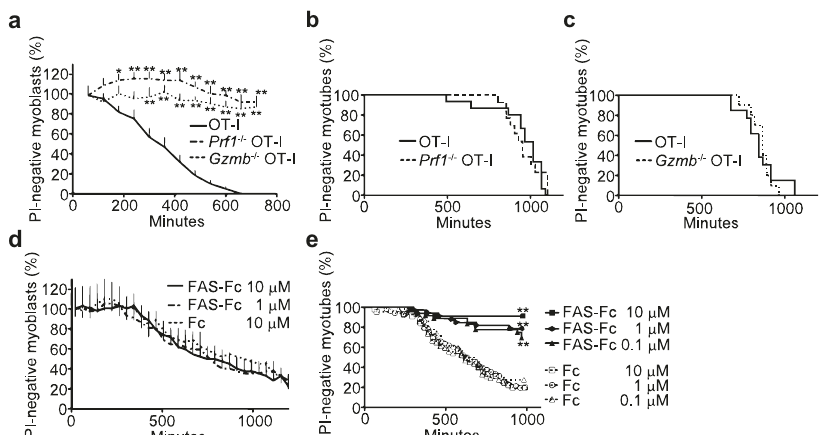
Fig. 2 Involvement of PRF1, GZMB, and FAS/FASLG in CTL-induced cell death of myoblasts and myotubes. a The viability of H2K b OVA-myoblasts co- cultured with OT-I CTLs ( n = 80), Prf1 − / − OT-I CTLs ( n = 59), or Gzmb − / − OT-I CTLs ( n = 61). The viability was visualized by PI staining and assessed with time-lapse imaging. Data are presented as mean and SD. Two-way analysis of variance (ANOVA) test, followed by Dunnett ’ s test. * p < 0.05, ** p < 0.01. b The viability of H2K b OVA-myotubes co-cultured with OT-I CTLs ( n = 30) or Prf1 − / − OT-I CTLs ( n = 26). c The viability of H2K b OVA- myotubes co-cultured with OT-I CTLs ( n = 42) or Gzmb − / − OT-I CTLs ( n = 40). d The viability of H2K b OVA-myoblasts co-cultured with OT-I CTLs in the presence of FAS-Fc chimera protein (1 μ M: n = 42, 10 μ M: n = 50) or the control Fc protein ( n = 48). Data are presented as mean and SD. e The viability of H2K b OVA-myotube co-cultured with OT-I CTLs in the presence of FAS-Fc chimera protein (0.1 μ M: n = 57, 1 μ M: n = 50, 10 μ M: n = 44) or the control Fc protein (0.1 μ M: n = 36, 1 μ M: n = 33, 10 μ M: n = 34). Representative data of three independent experiments are shown. Log-rank test, followed by Holm – Sidak multiple comparisons. ** p < H2K b OVA-myotubes, the levels of HMGB1, IL-1 α and IL-6 were increased in the co-culture of myotubes and OT-I CTLs (Fig. 4g – i). HMGB1 has different redox isoforms with distinct